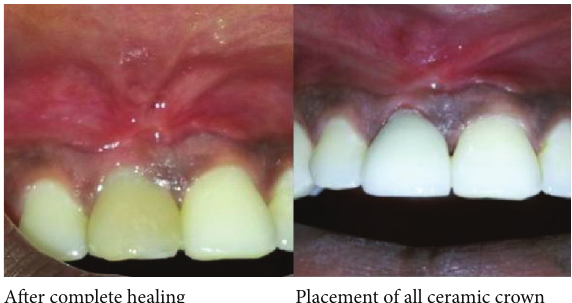
Figure 4: Postoperative photograph with all ceramic